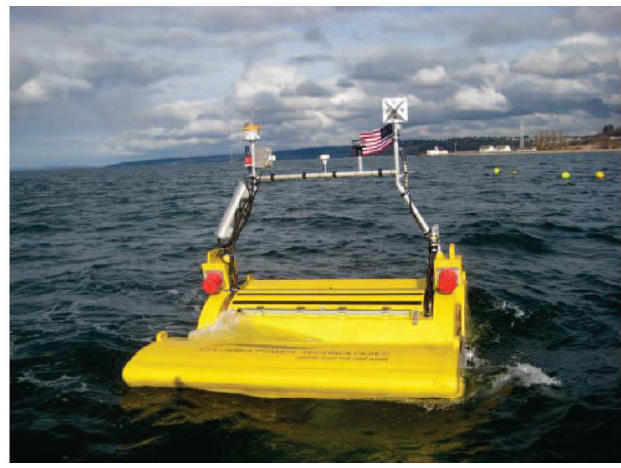
Figure 17. SeaRay 1:7 scaled model being tested in real seas [4]